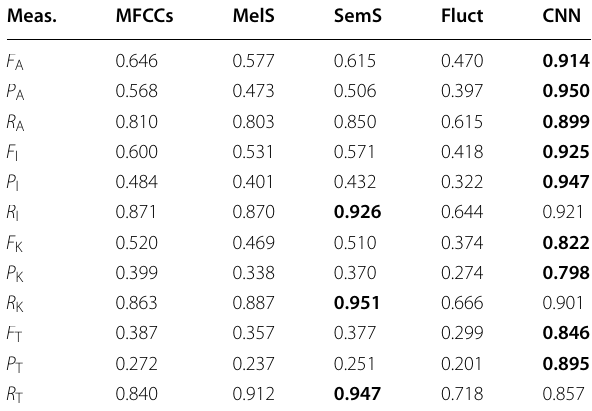
Table 4 Architecture blocks for four networks inspired by previous work. Music segmentation: CNN-GrillSchlüter: adaptation after [62]. Instrument recognition: CNN-AlexNet: adaptation after [63]; CNN-Han: adaptation after [64, 65]; CNN-VGG16: adaptation after numbers of output neurons are provided in square brackets